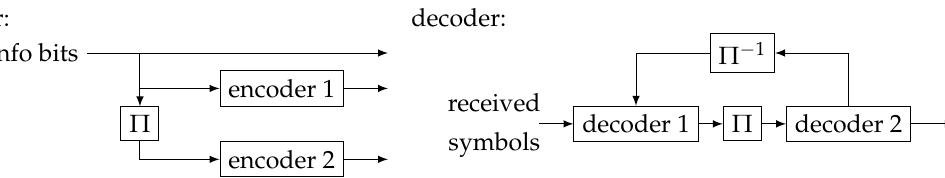
Figure 11. Encoder and decoder of a turbo